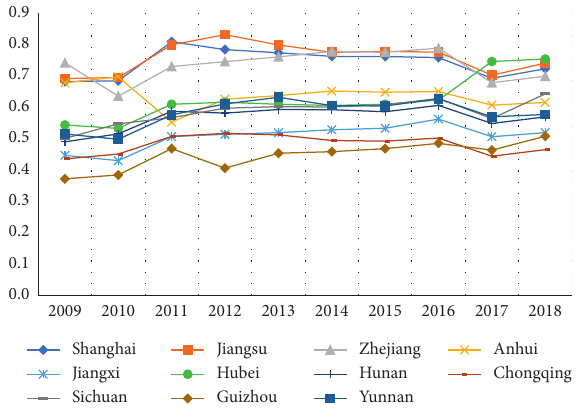
Figure 4: Evolution of the system’s DCC.